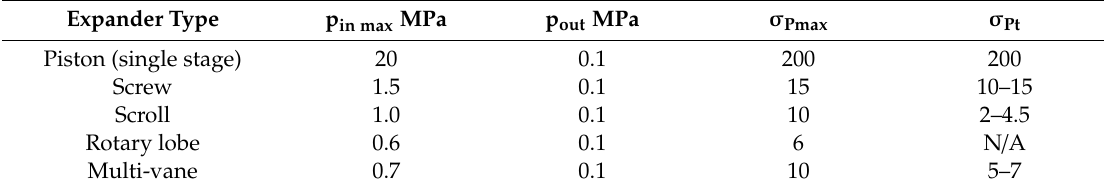
Table 1. Range of the working pressures, maximum, and typical pressure expansion ratios of di ff erent types of volumetric machines